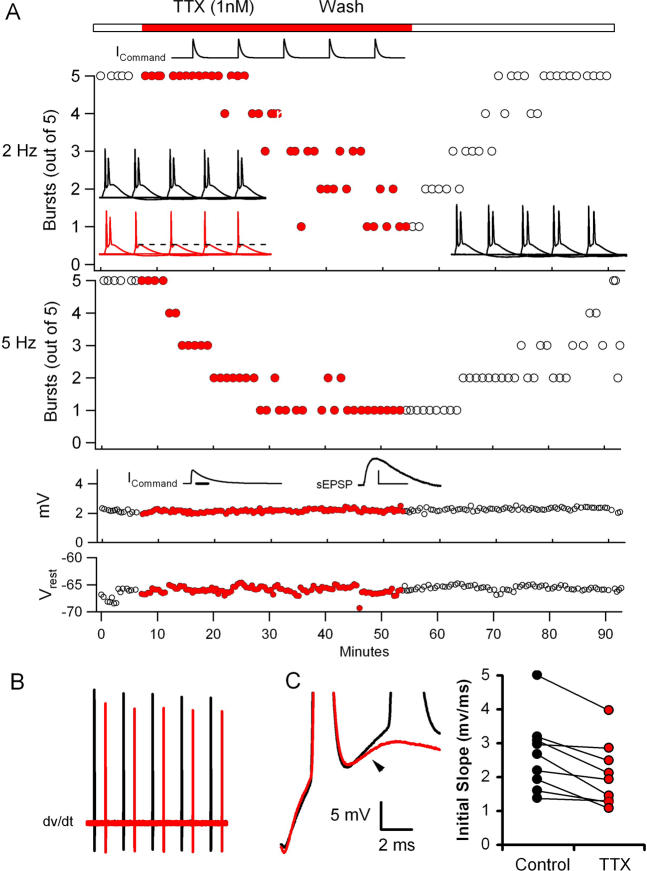
Modest Reduction of Na+ Current Induces a Frequency-Dependent Output-Mode Transition from Bursting to Single Spiking(A) The number of bursts in response to a train of five suprathreshold sEPSC currents injections at 2 and 5 Hz delivered every 20 sec before, during (red), and after bath application of 1 nM TTX. The black (left), red, and black (right) insets show overlays of the action potential transition in response to five 2-Hz sEPSC inputs (I
Command) under baseline, TTX (1 nM), and wash conditions, respectively. Note the dashed line in the TTX (red) trace shows the lack of change in the ADP during the stimulus train. The lower panels show no change in a subthreshold sEPSP or resting potential (mV) in response to TTX. The insets show an expanded sEPSC (left; scale bar, 5 ms) and the corresponding sEPSP (right; scale bars, 1 mV vertical, and 20 ms horizontal) that was used to monitor changes in passive properties of the cell.(B) A representative trace showing the reduction in the dV/dt of the action potentials before (black) and after 1 nM TTX (red). The average reduction in the first action potential dV/dt after 1 nM TTX was 9% ± 2% (n = 5).(C) An overlay (left tracing) showing the reduction in the initial slope of the ADP before (black burst) and after (red single spike) 1 nM TTX (All traces in [A], [B], and [C] were taken from the same recording). The graph on the right shows that the low concentrations of TTX (1–5 nM) necessary to induce a switch from bursting to single spiking decrease the initial slope (as illustrated in [C]) of the ADP for a burst (black) and compared to the first transition to a single spike (red) at low frequencies (less than 0.1 Hz) that alone do not influence the burst-single spike transition (ADP reduction = 23% ± 6%, p < 0.003, n = 9).